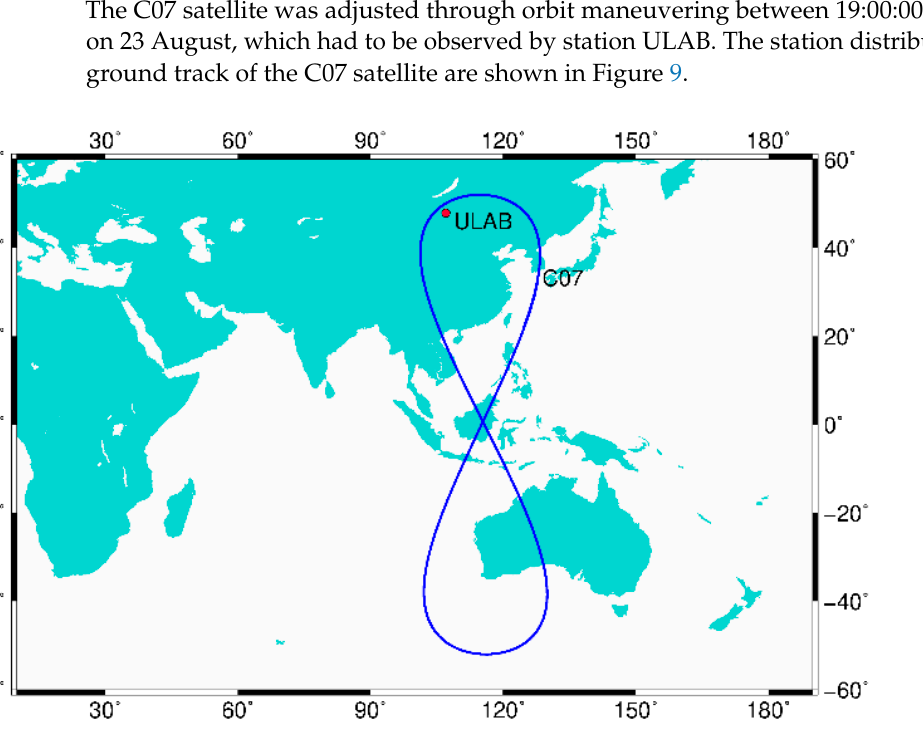
in Scheme 2. The results of real-time precise point positioning (PPP) from 17:00:00– 23:59:59 on 23 August 2019 are shown in Figure 10. Figure 10. Bias of real-time precise point positioning (PPP) of spatial coordinates. In Figure 10, the x-axis is the epoch time and the y-axis is the value of the bias of real- time PPP of spatial coordinates. The red points denote the real-time PPP bias after the first estimation of Scheme 1, which shows the error of the ultra-rapid precise products includ- ing the maneuvered satellite. The black points denote the real-time PPP bias after iterative estimation of Scheme 1, which indicates the real-time positioning accuracy of PPP by us- ing the ultra-rapid precise orbit and clock products including the maneuvered satellite, and the green points denote the bias of Scheme 2. The bottom part is a detail of the top